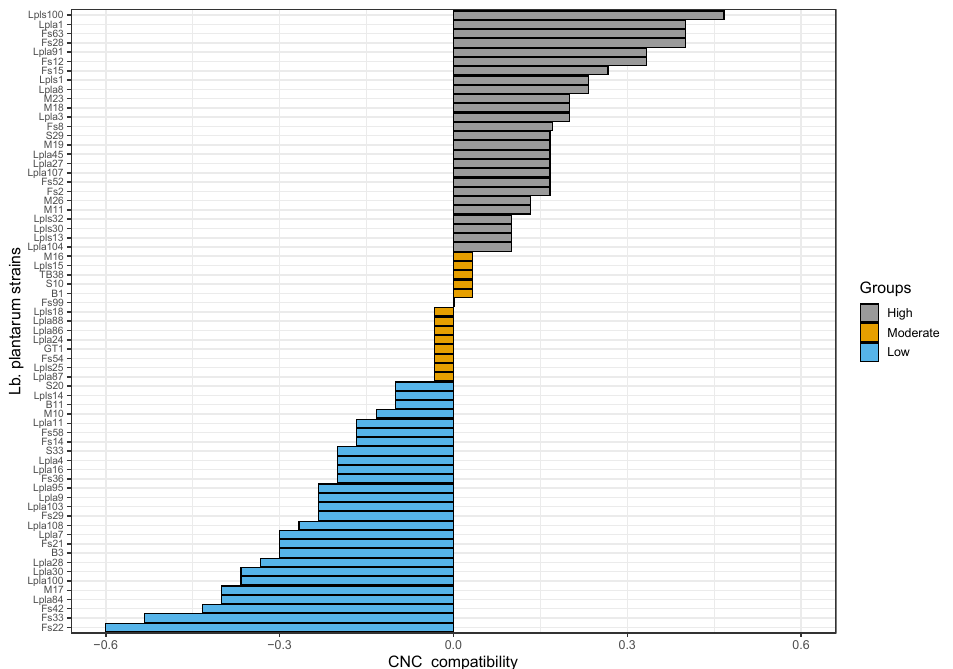
Figure 2. Barplots of the CNC_compatibility index expressed by sixty-seven strains of Lactiplantibacillus plantarum against Staphylococcus xylosus MVS9. The different colors indicate strains grouped on the basis of high, moderate, or low compatibility.